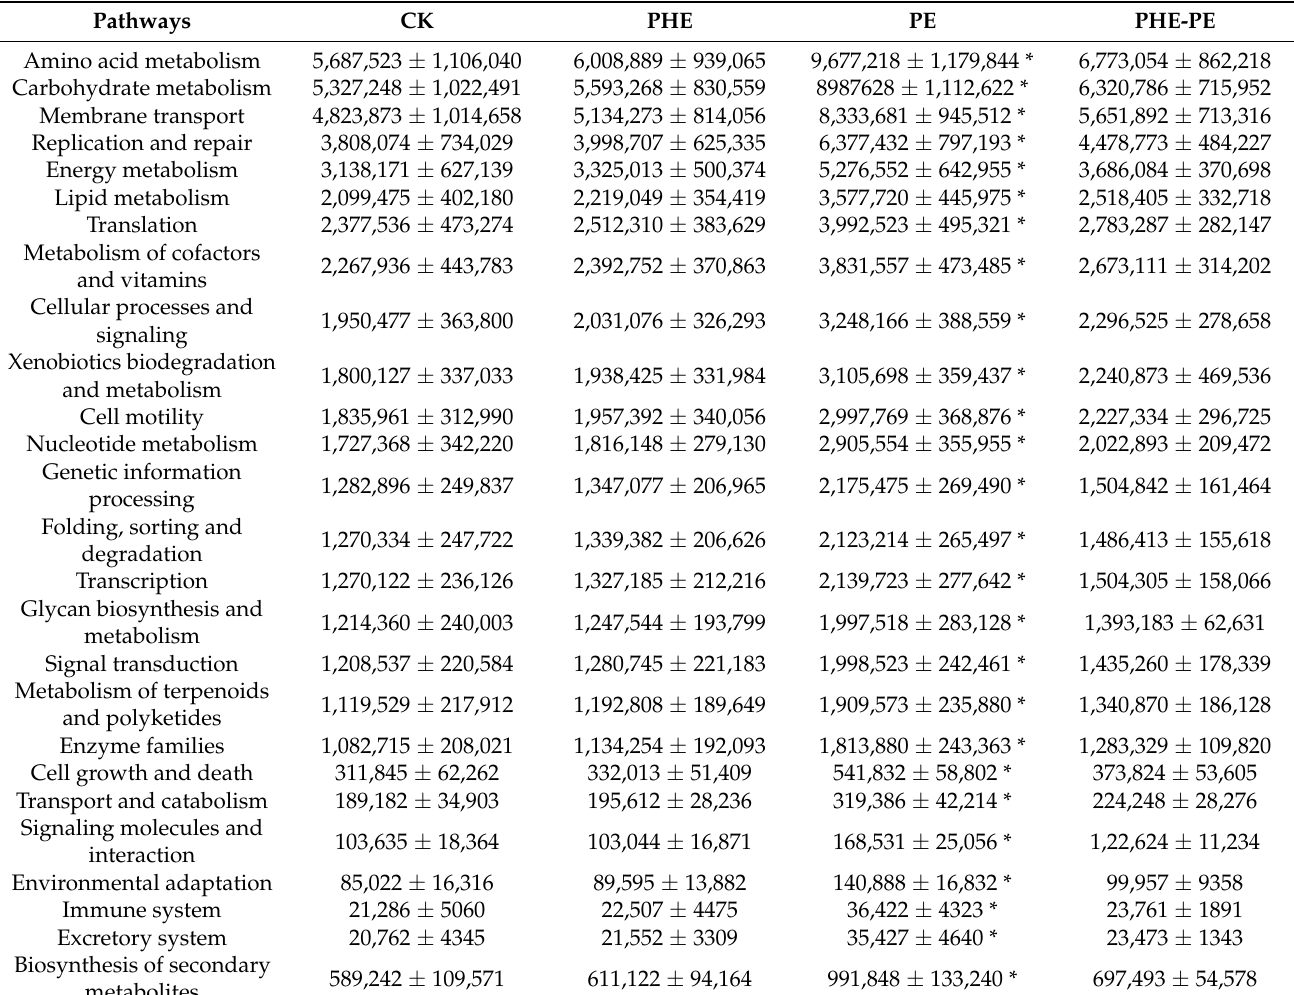
Table 4. Metabolic pathway abundance based on KEGG database at level 2.